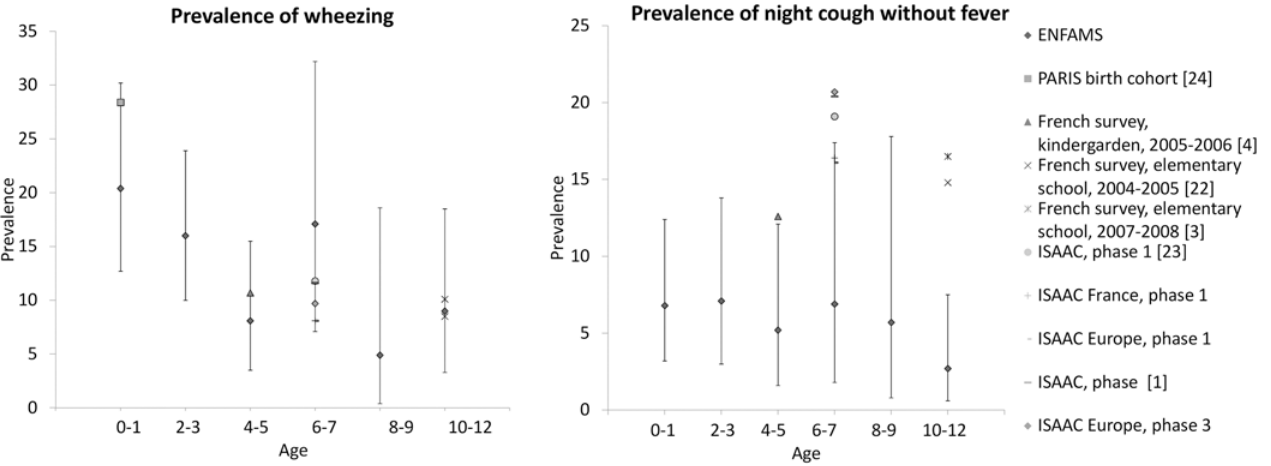
Fig 3. Prevalence of wheezing and night cough without fever — comparison between different